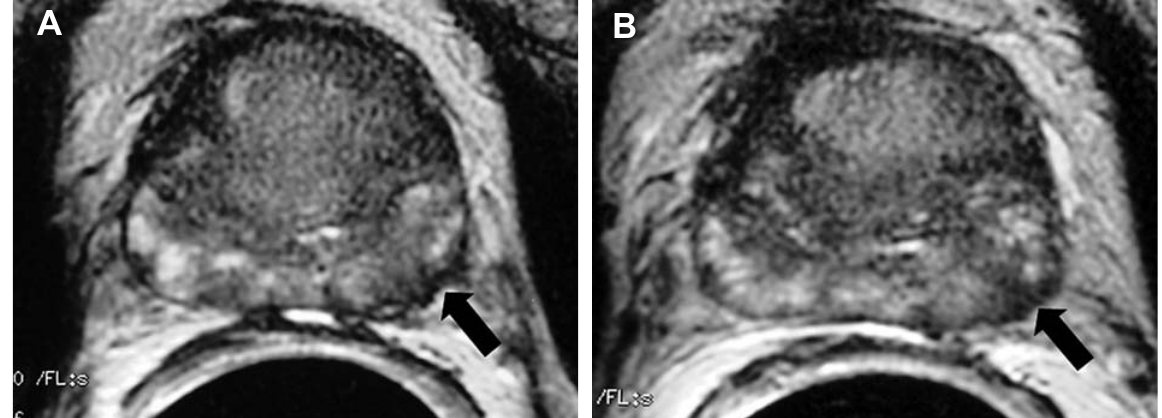
Figure 4 – Prostate cancer. A) and B) E-MRI, axial plane, T2-weighted images showing focal area of low signal intensity in the lat- eral aspect of the left peripheral zone (arrow) associated with irregular thickening of the capsule of the prostate. TRUS-guided